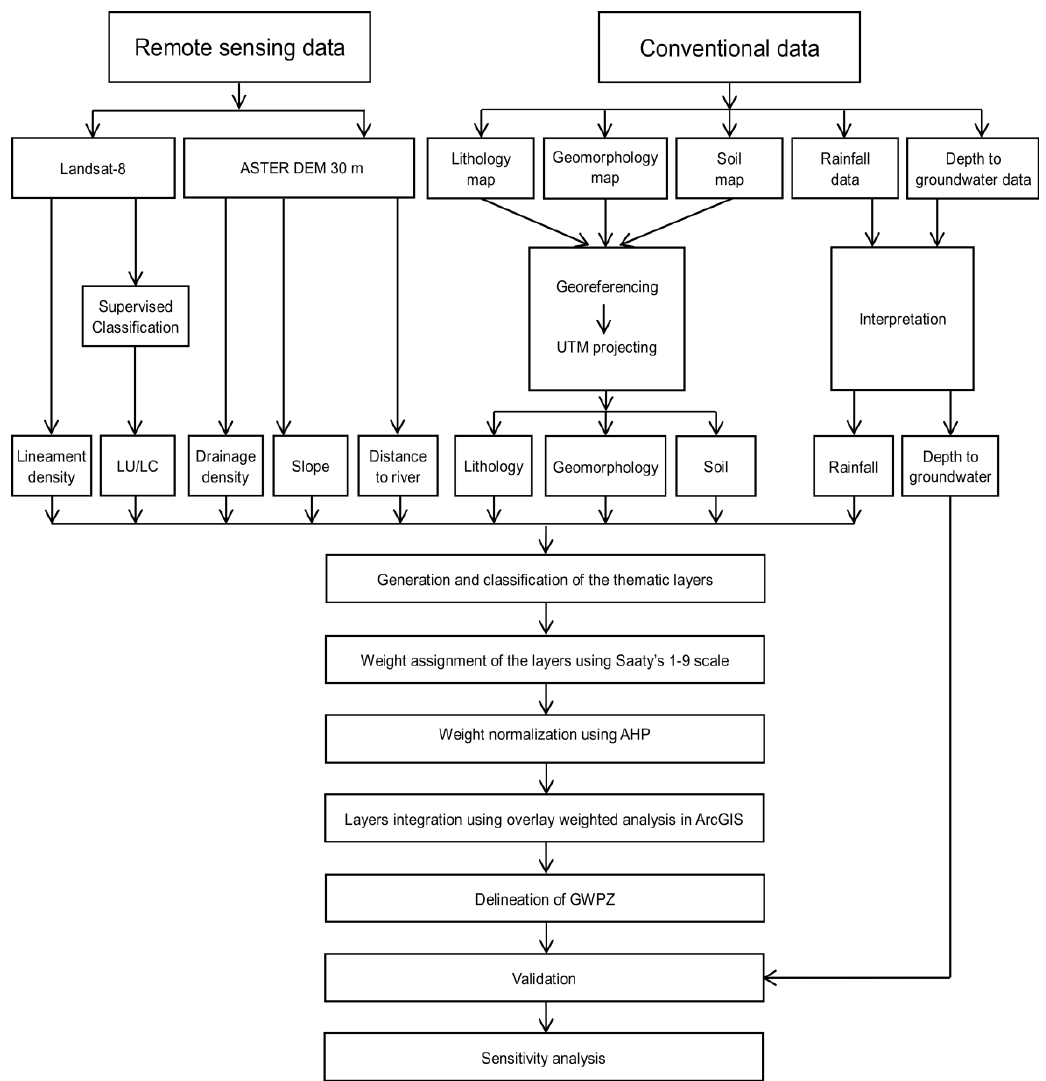
Figure 2. Flowchart for the identification of groundwater potential zones (GWPZs).